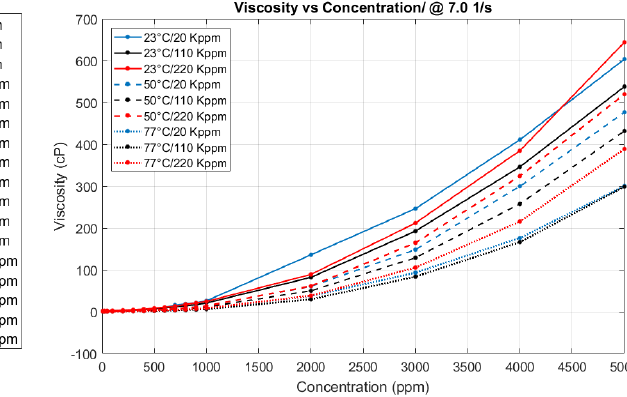
Figure 12: Viscosity versus Concentration at 7.0 1/s for all condi- tions